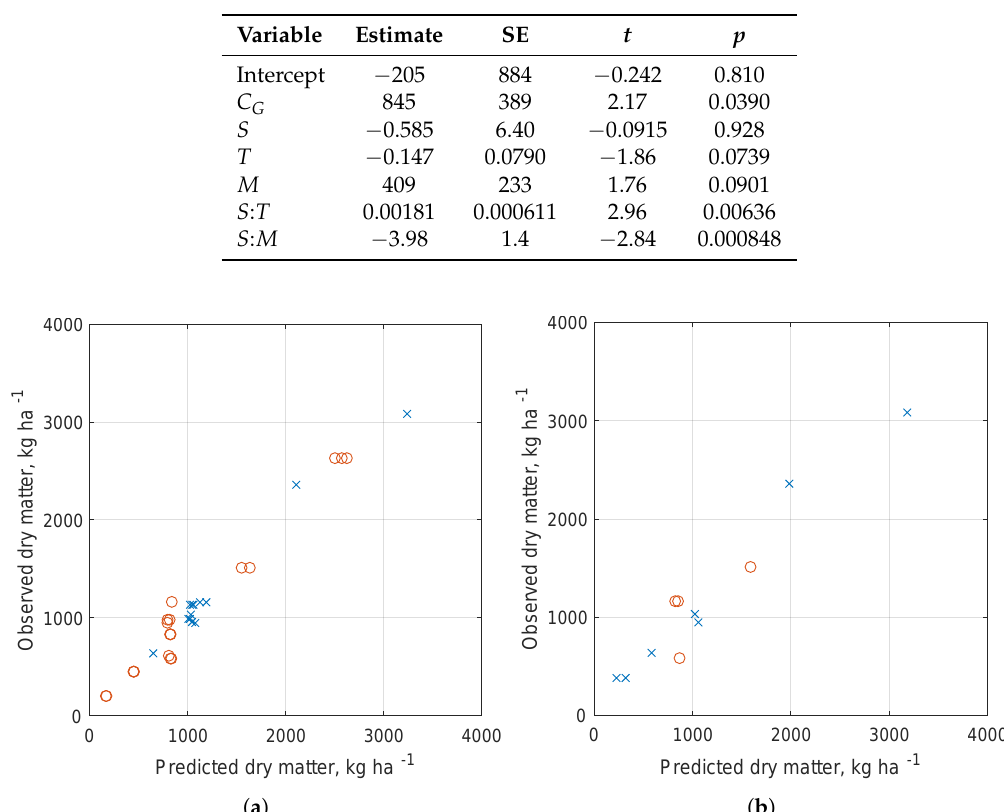
Table 3. Estimated variable weights for the final total dry matter model. C G is the Clover Coverage. S is the accumulated Sunshine hours since last harvest. T is the Temperature sum since last harvest. M is a factor variable describing the Mixture. SE is the Standard Error. t is the t -statistic for a test for which the coefficient is zero. p is the p -value for the t -statistic (stepwise linear regression (stepwiselm)